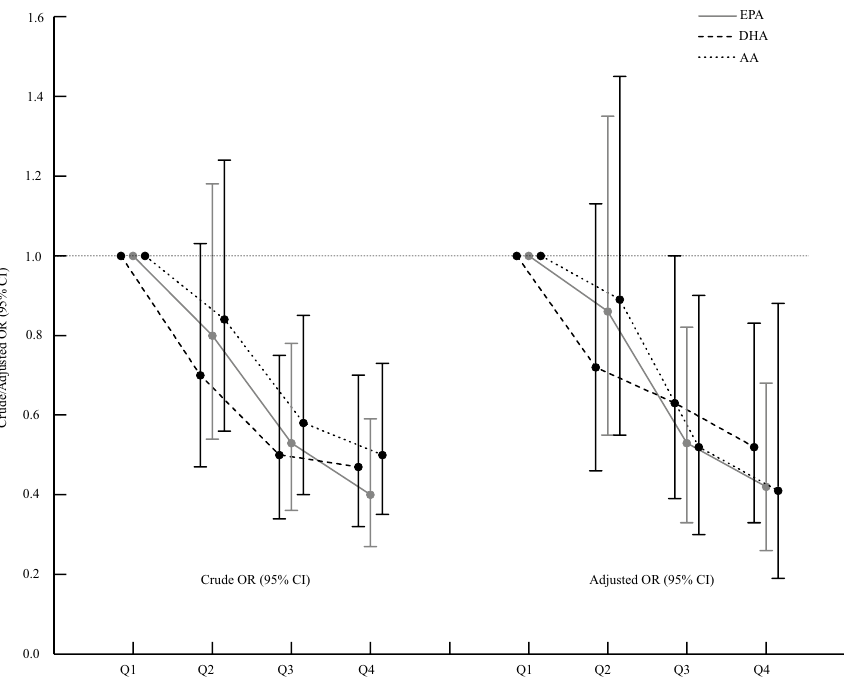
Figure 1. The risk of preeclampsia based on the intake of dietary EPA, DHA, and AA intake levels; Error bars indicate 95% confidence intervals. Abbreviations: EPA, eicosapentaenoic acid; DHA, docosahexaenoic acid; AA, arachidonic acid; 95%CI, 95% confidence